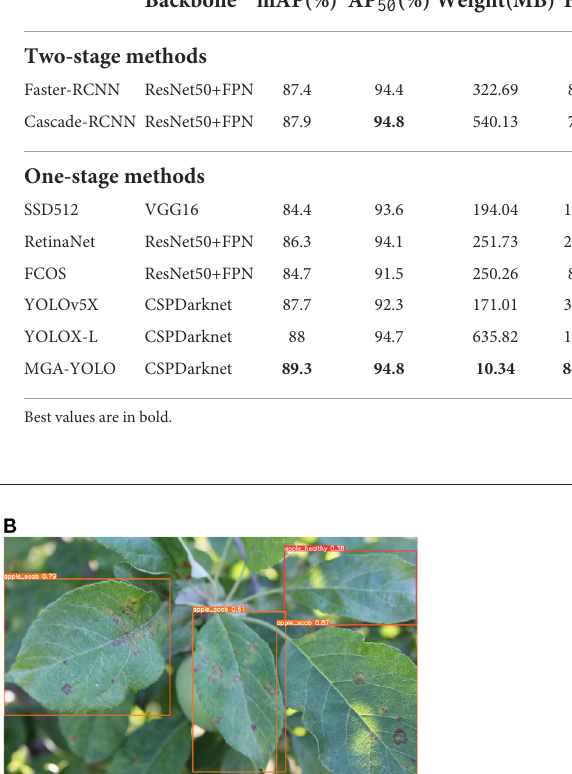
TABLE 3 Comparison of SOTA models.